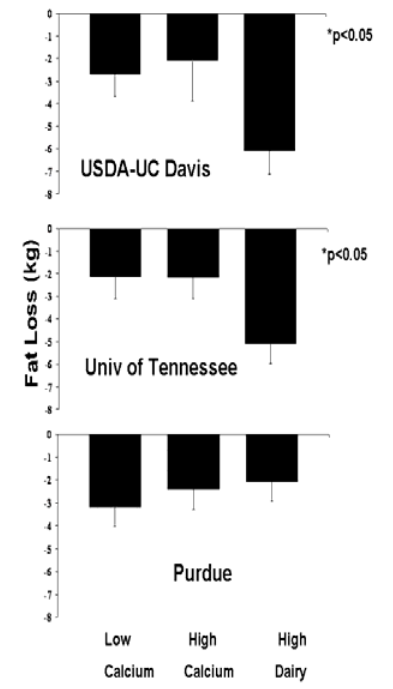
Figure 2. Site-Specific effects of dietary treatments on fat loss in adherent subjects. Top panel: USDA Davis. Middle panel: University of Tennessee. Bottom panel: Purdue. All data are presented as mean ± standard